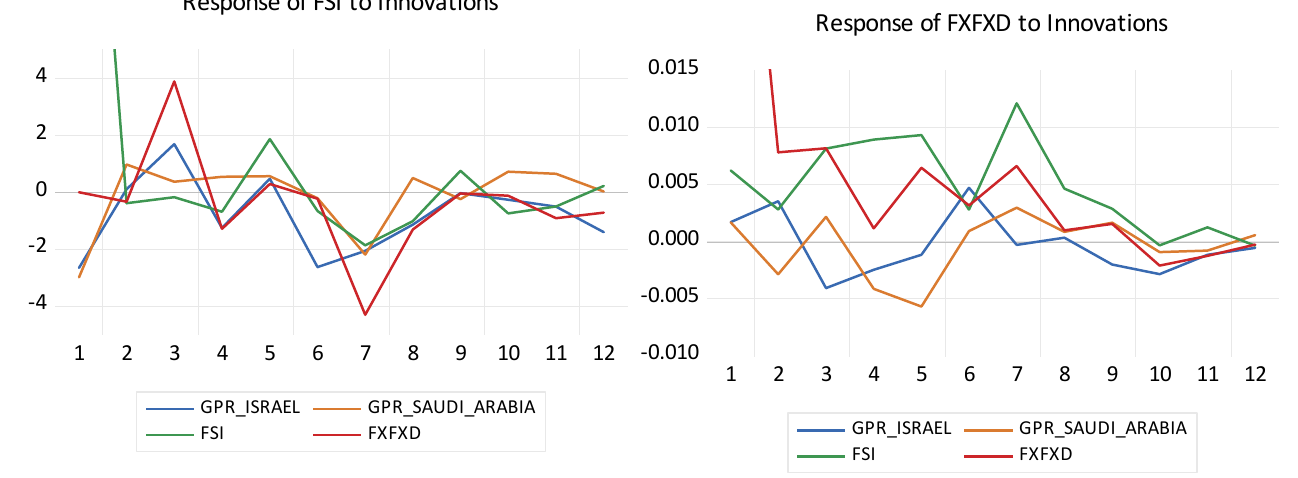
Figure 3. Response of output to FSI and FXFXD shocks.